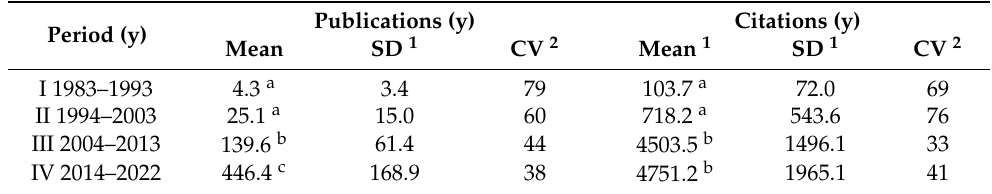
Table 1. Comparation of publications and citations per year among